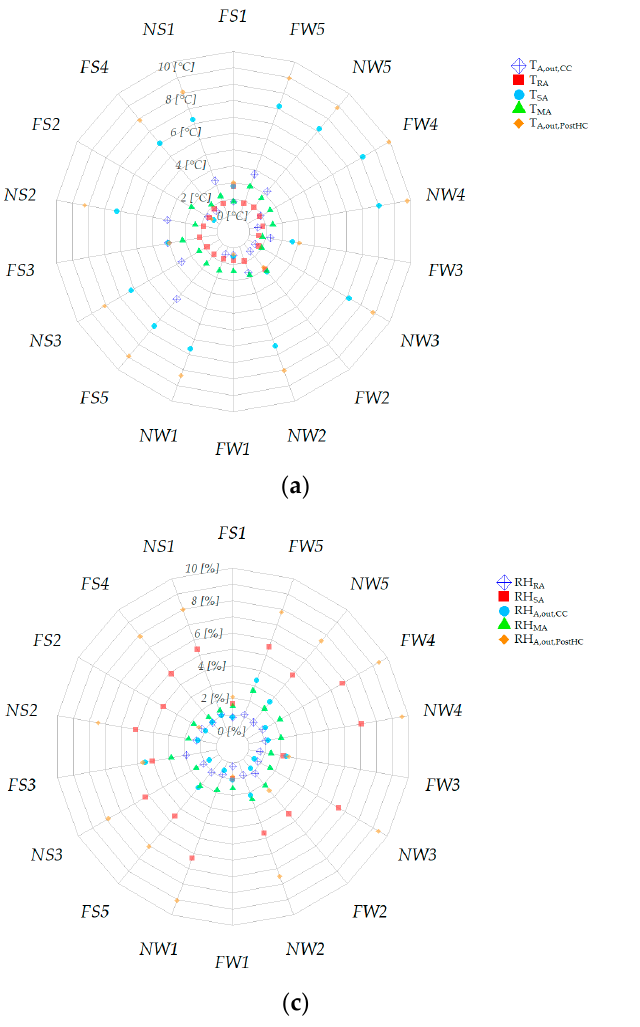
Figure 7. Standard deviations of ( a ) air temperature, ( b ) water temperature, ( c ) air relative humidity, and ( d ) water volumetric flow rate measured during faulty and normal tests.